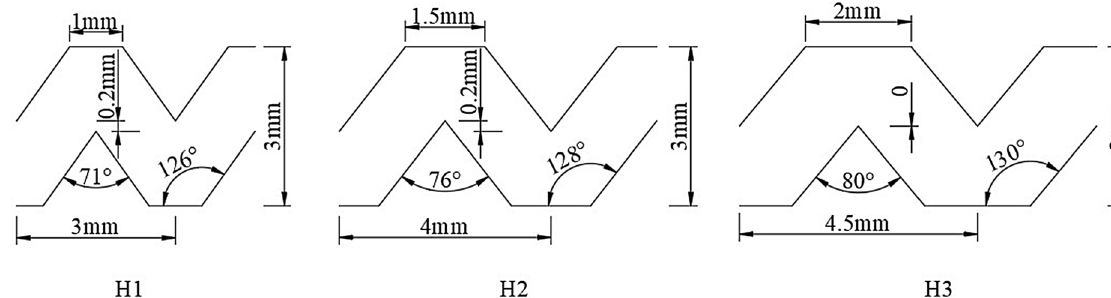
Figure 1. Photograph of drip irrigation tape.